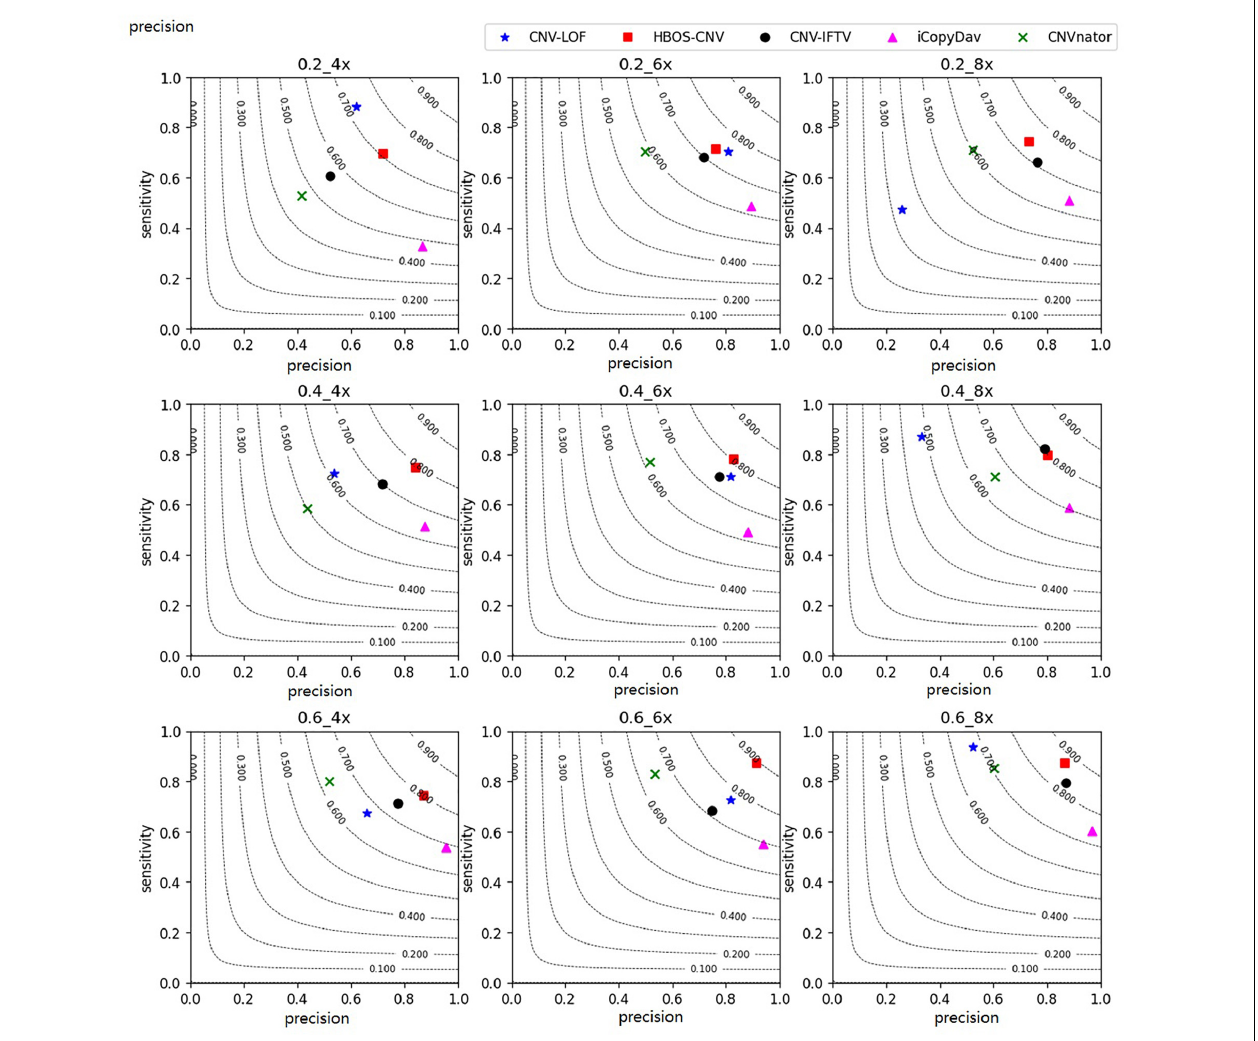
FIGURE 4 | Performance comparisons between the five methods with the bin-size of 500 in terms of sensitivity, precision, and F1-measure on simulation datasets. The F1-measure levels are shown in grey curves ranging from 0.1 to 0.9.